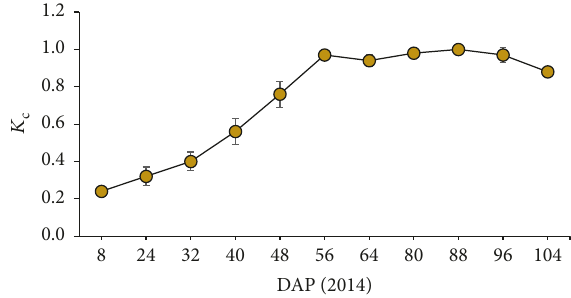
Figure 7: Crop coefficient curve of corn throughout the 2014 growing season. Vertical bars represent standard deviation